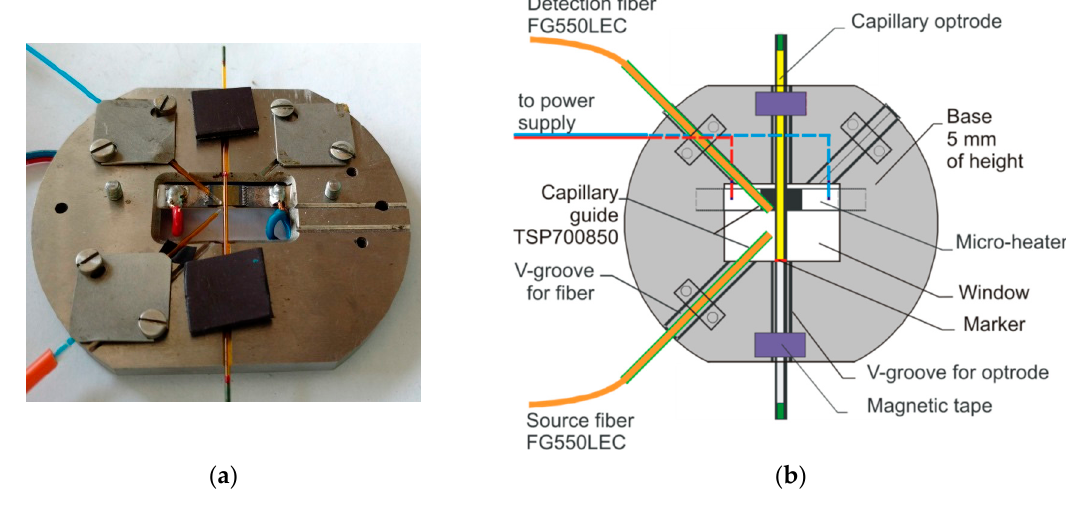
Figure 5. The head base with optrode: ( a ) View; ( b ) Scheme.